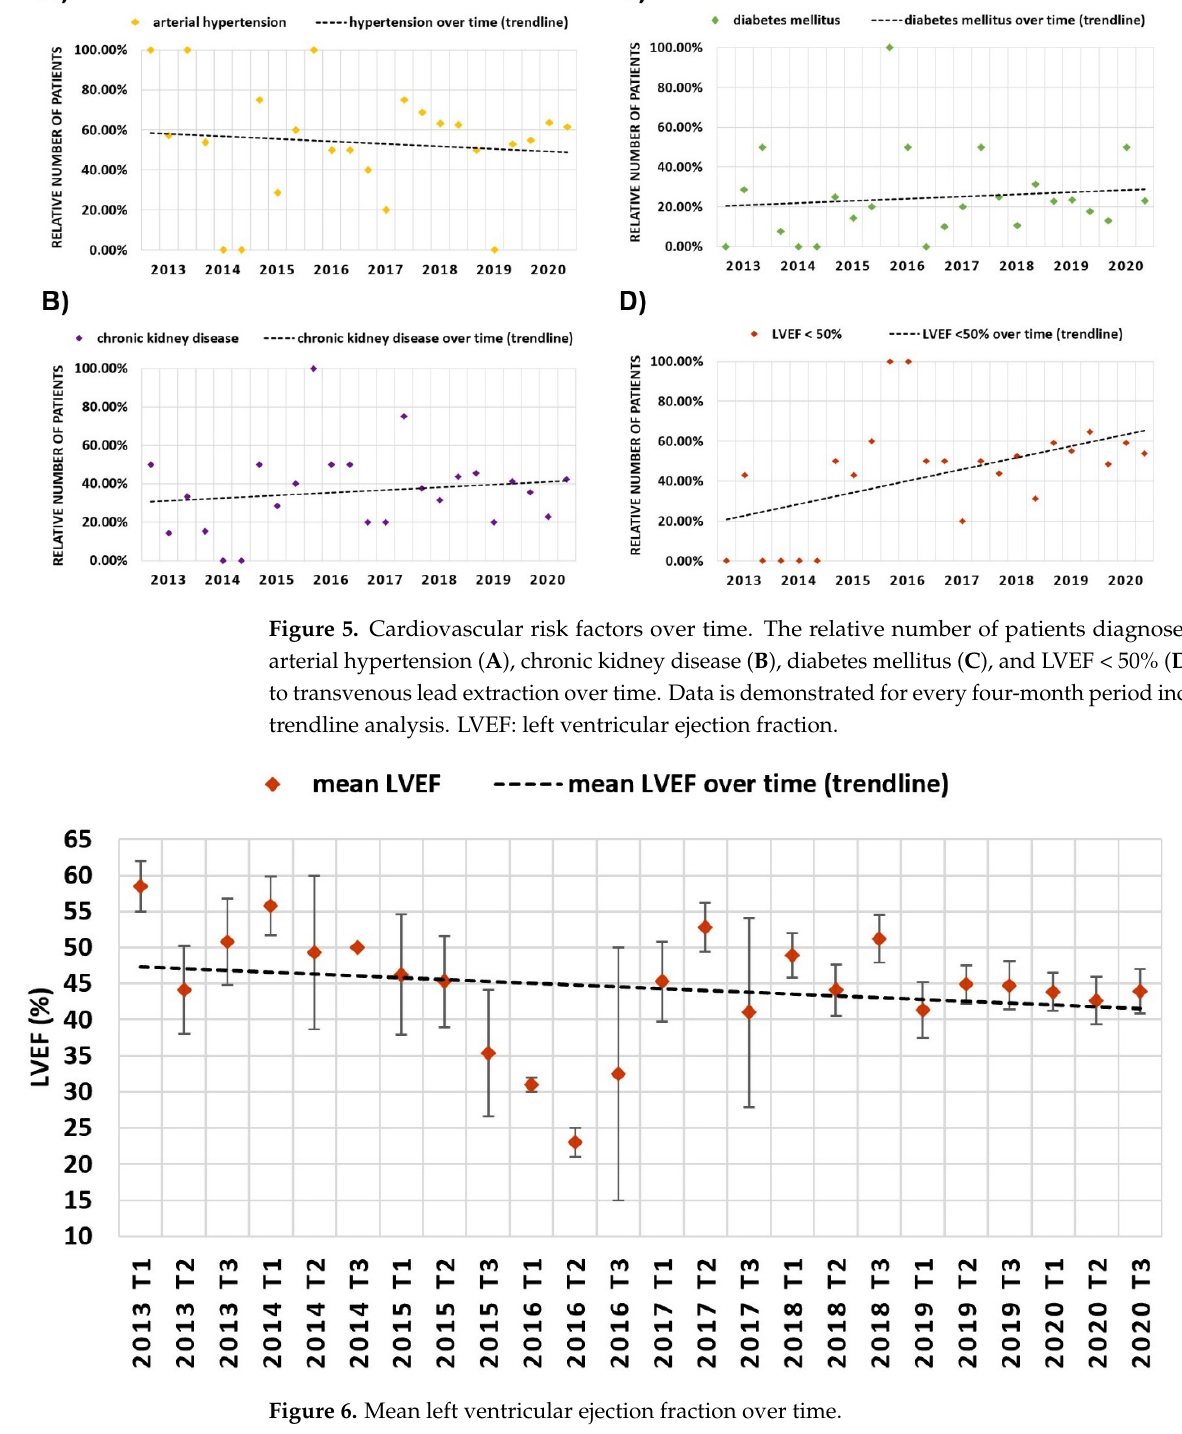
Figure 6. Mean left ventricular ejection fraction over time.